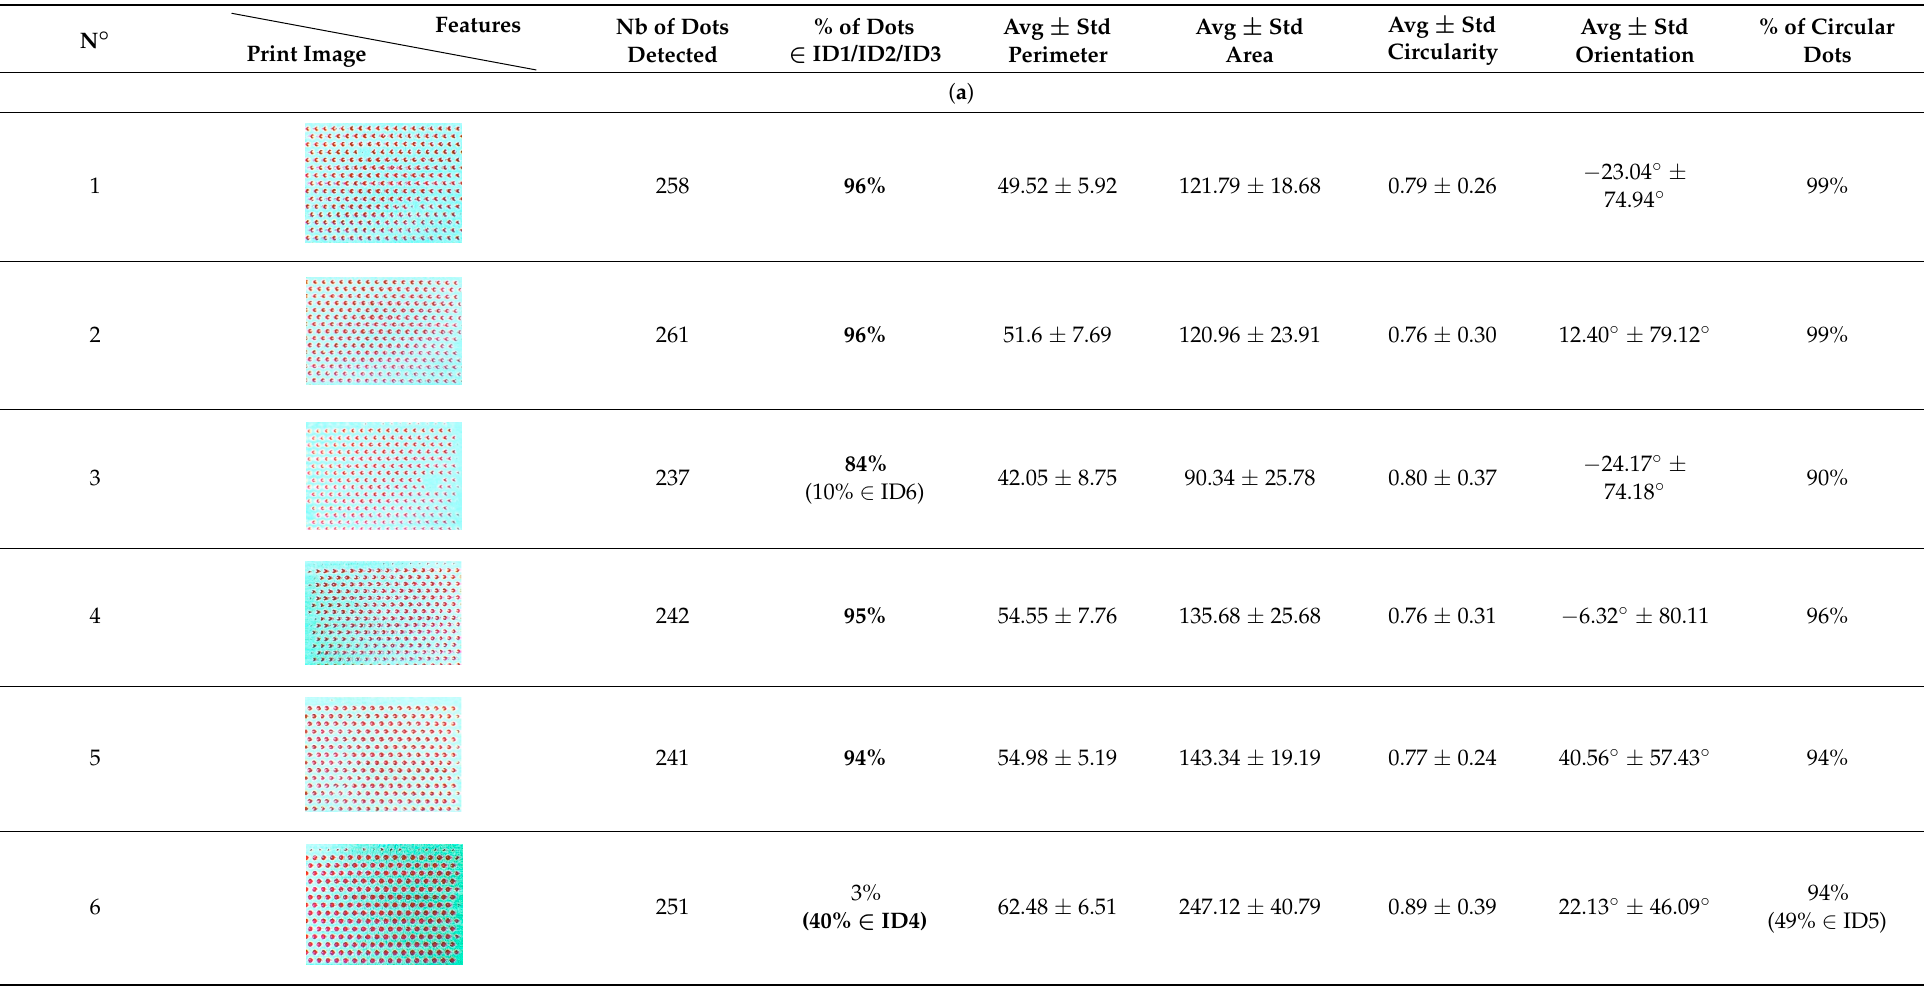
Table 1. ( a ) Statistical values computed for printed magenta dots. The most significant values are highlighted in bold. ( b ) Statistical values computed for reprint magenta dots. The most significant values are highlighted in bold.